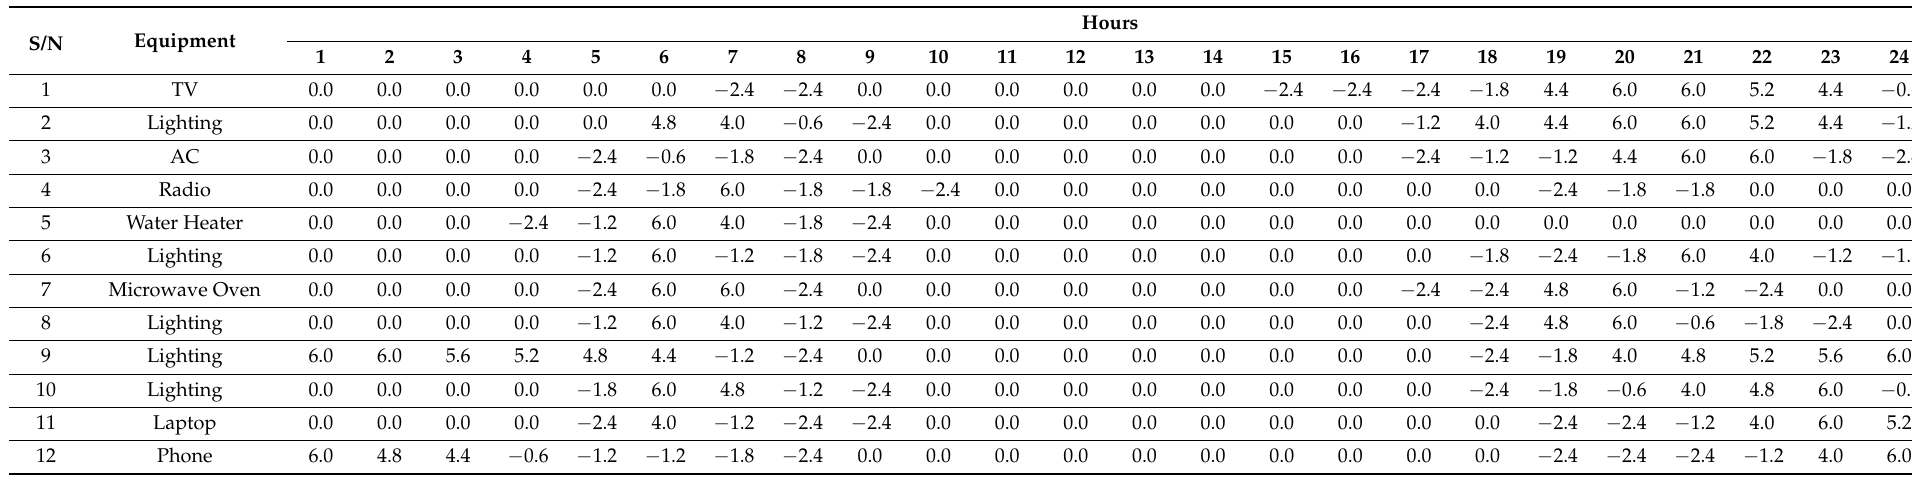
Table 6. Time-based satisfaction.